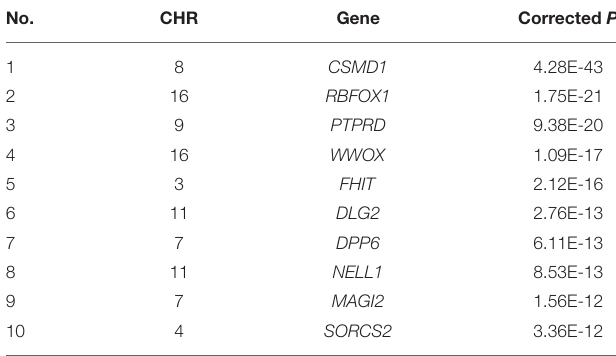
FIGURE 8 | The accuracy of the random forest on different subsets.